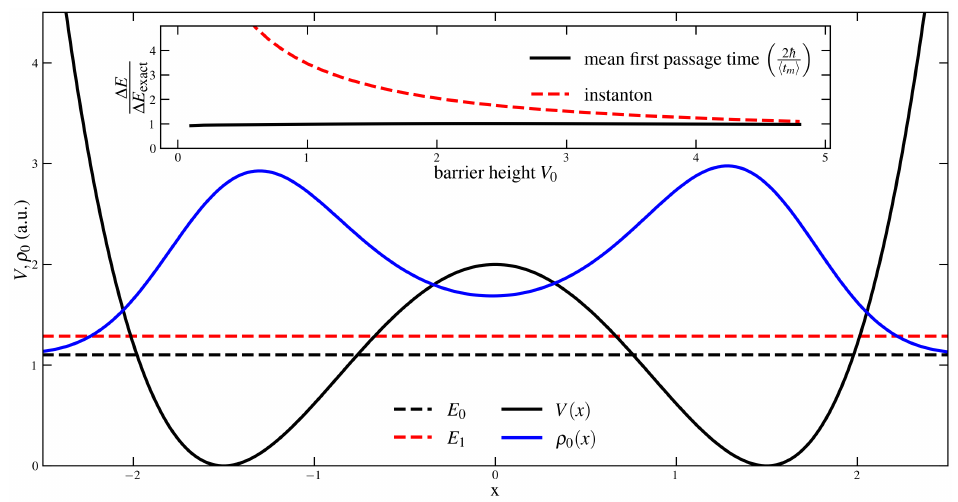
Figure 2. The big figure shows the ground state probability ρ 0 (solid blue), the first two mean energies E 0 (dashed black) and E 1 (dashed red) and the potential V (solid black). The inset compares the ratio of predicted and exact energy splitting ∆ E = E 1 − E 0 of the mean first passage time (solid black) and an instanton approximation [53] (dashed red) depending on the barrier height V 0